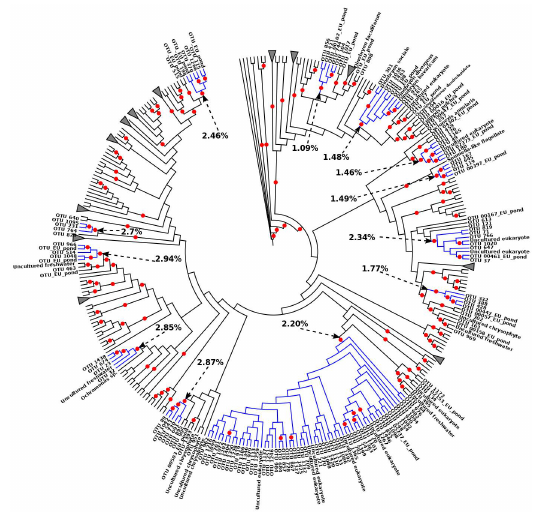
Figure 5. Reduced Chrisophyceae ML tree (See full version of the tree in Figure S11). Potential species flocks are indicated in blue. The percentages indicate the average divergence of the sequences within each flock. Red circles correspond to bootstrap supports > 60. Microorganisms 2019 , 7 , x FOR PEER REVIEW